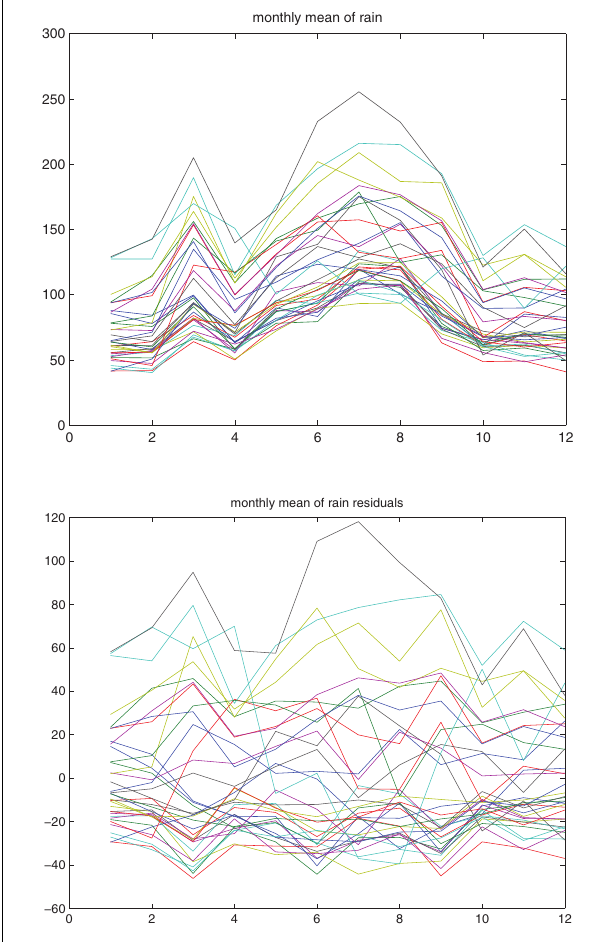
36 stations, for each of the 12 months. Below: The residual rainfall at each of the